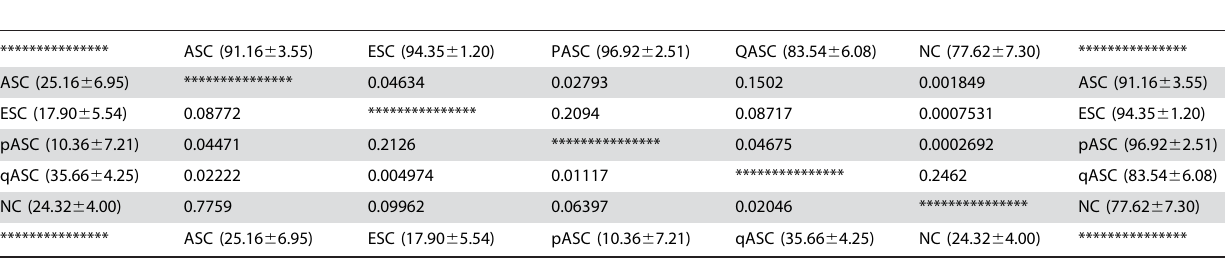
Table 9. The distribution of promoter usage in the different SC types and the negative controls (NCs); the upper right section of the table considers CpG-richness, whilst the lower left section considers AP